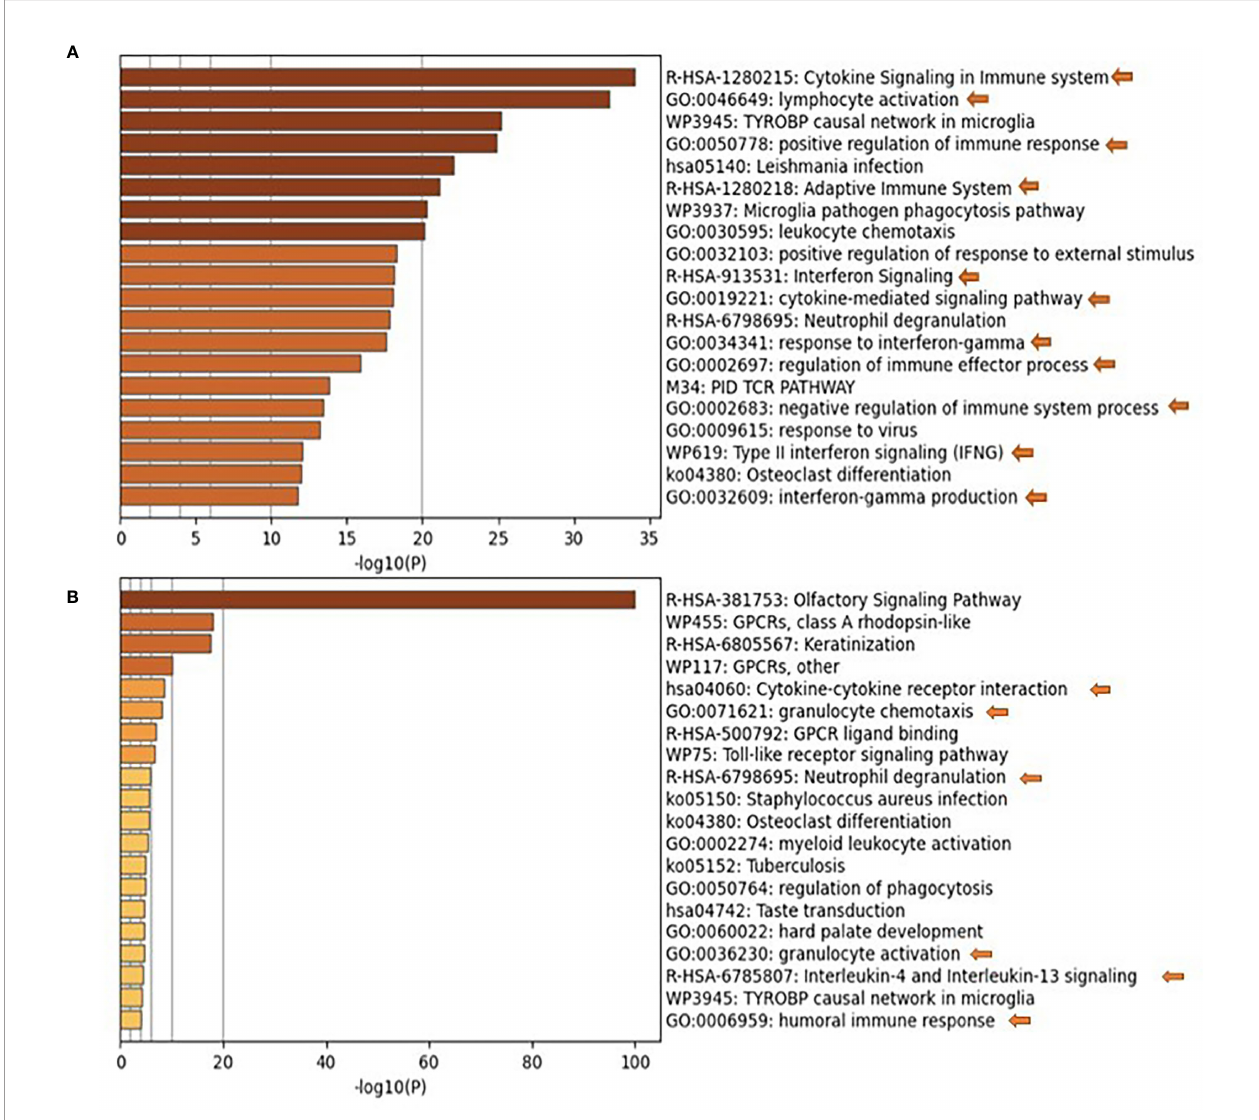
FIGURE 1 | Pathways Enrichment is the nasopharyngeal swab samples of moderate and severe COVID-19 patients. Functional clustering and pathway analysis of the signi fi cantly upregulated genes in the nasopharyngeal swab samples collected from (A) moderate and (B) severe COVID-19 patients in comparison to healthy patients. DEGs were identi fi ed using DESeq2 algorithm; the genes were fi ltered according to adjusted p-value of <0.05 and fold change >2 or <0.5. The functional clustering analysis was performed using Metascape; p-value cut-off for pathways inclusion was